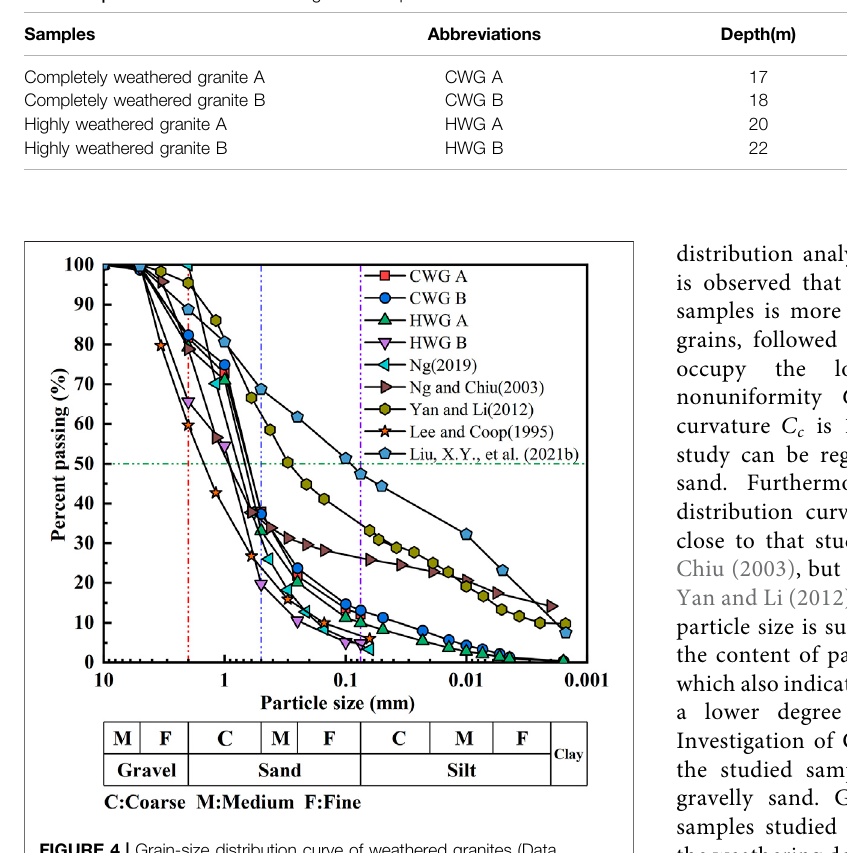
FIGURE 4 | Grain-size distribution curve of weathered granites (Data from Lee and Coop (1995); Ng and Chiu (2003); Yan and Li (2012); Ng et al. (2019); Liu X. et al. (2021).